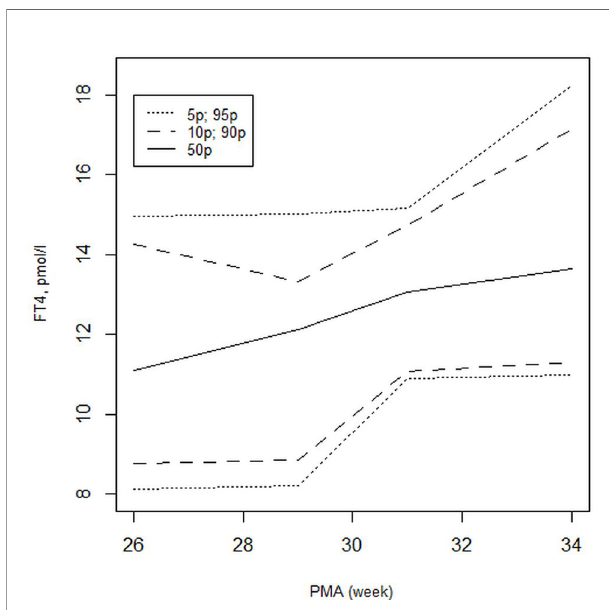
FIGURE 4 | Distribution of FT4 (pmol/l) values presented as the 5th to 95th percentiles for FT4 in preterm infants born with GA <33 weeks at PNA 2